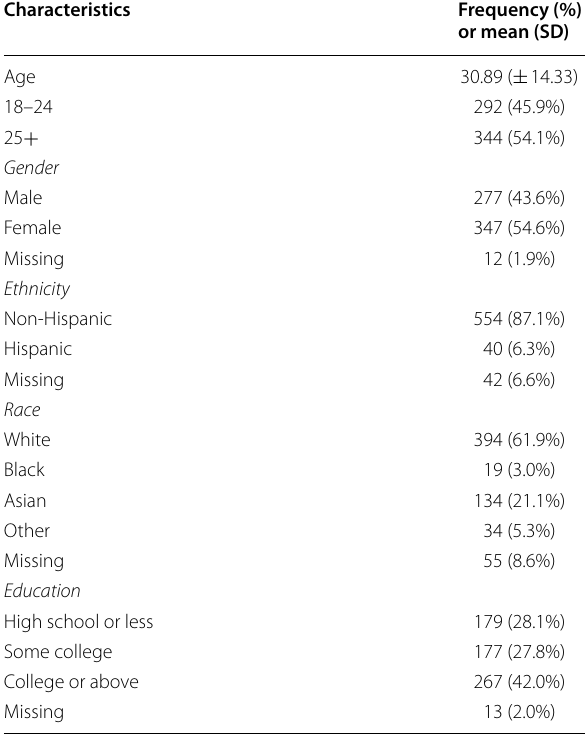
Table 1 Characteristics of